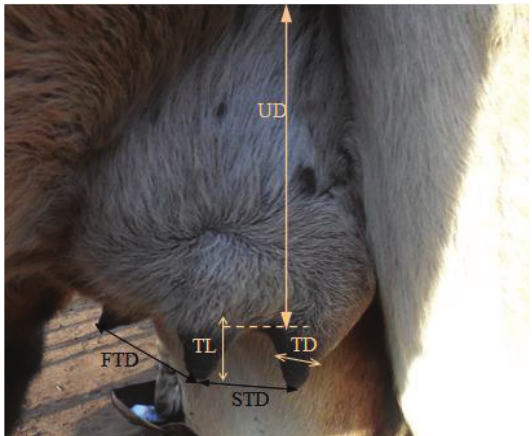
Figure 1. Udder and teats measurements of dromedary camels. TD: Teat diameter; TL: Teat length; STD: Side teats distance; FTD: Fore teat distance; UD: Udder depth. STD: Side teats distance; FTD: Fore teat distance; UD: Udder